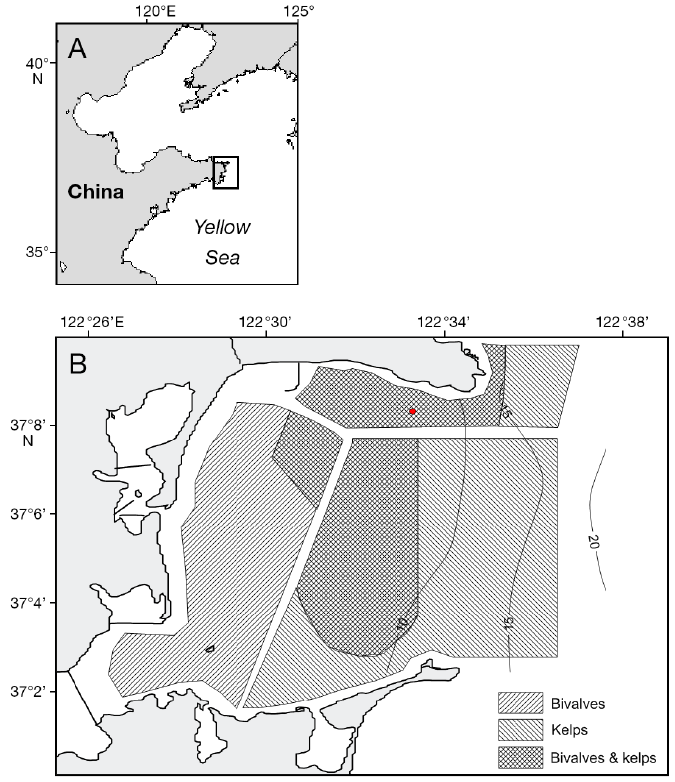
Fig. 1. (A) Location of Sanggou Bay (rectangle) at the eastern end of Shandong Peninsula, China and (B) location of the experimen- tal site (red dot) in the northern part of the bay, within the kelp and bivalve mariculture area. Areas of kelp or bivalve monocul- ture are also indicated. Contour lines: 10, 15 and 20 m water